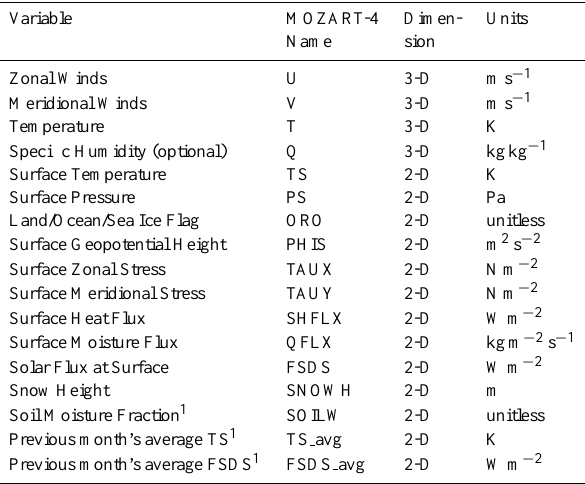
Table 1. Meteorological inputs required for